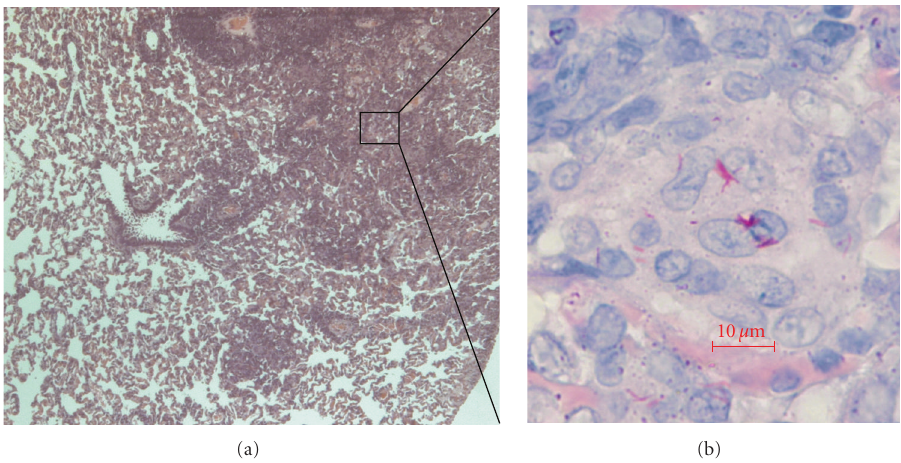
Figure 5: H&E at 100 × magnification (a) and ZN stain at 1000 × magnification (b) of a lung granulomatous lesion at 4 weeks post